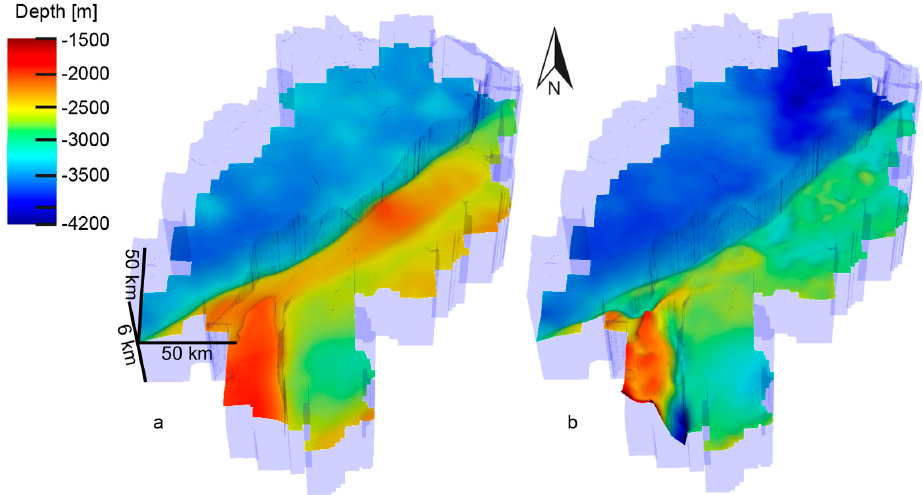
Figure 7. Depth of the 100 °C isotherm of ( a ) the conductive steady-state heat transport simulation and ( b ) the thermo-hydraulic steady-state simulation. The transparent blue block indicates the model domain in three dimensions. The results are shown with ten times vertical exaggeration.